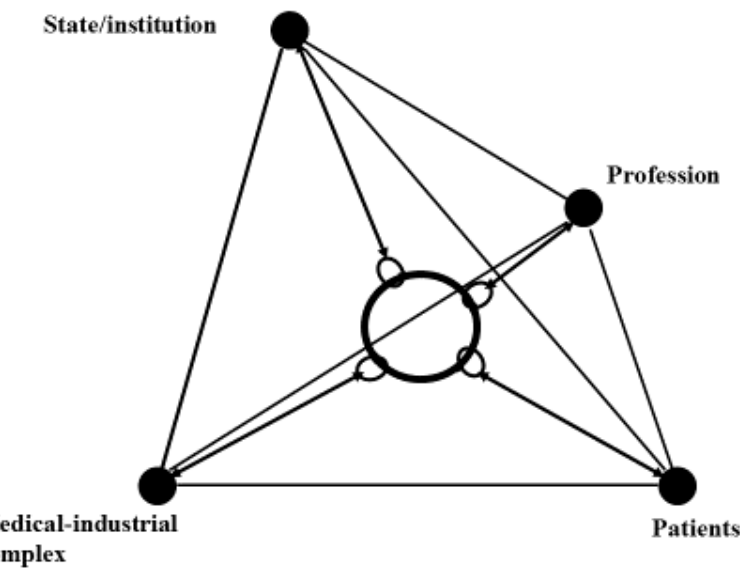
Countervailing powers: the